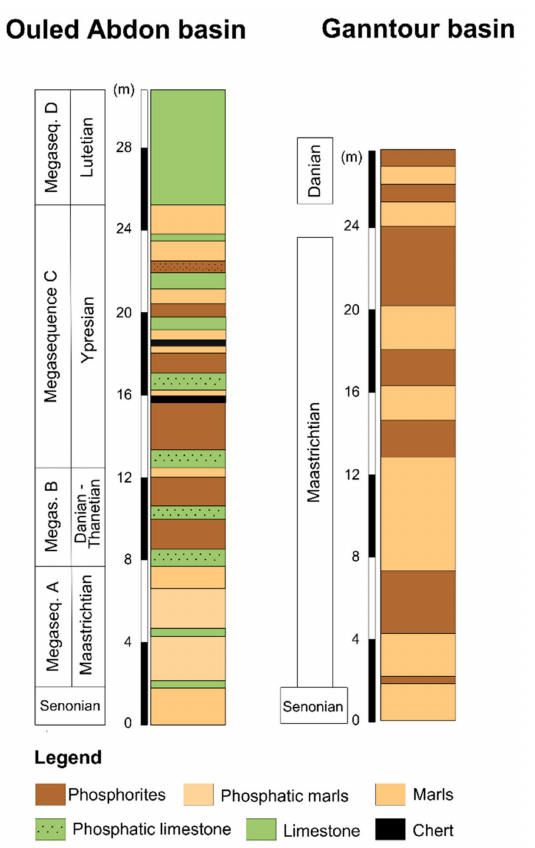
Figure 7. Stratigraphy of the P-bearing sequences of the Ouled Abdon and Ganntour basins of Morocco